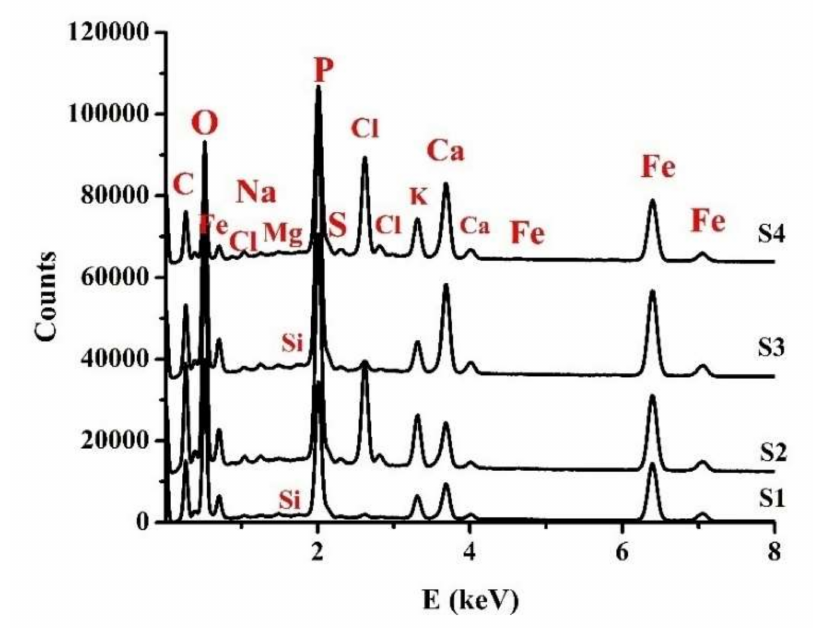
Figure 2. Energy-dispersive spectra of samples S1, S2, S3, and